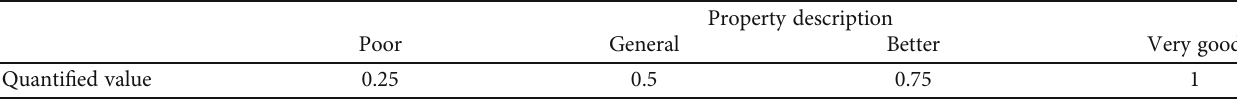
Table 3: Personnel ability description quantitative table.